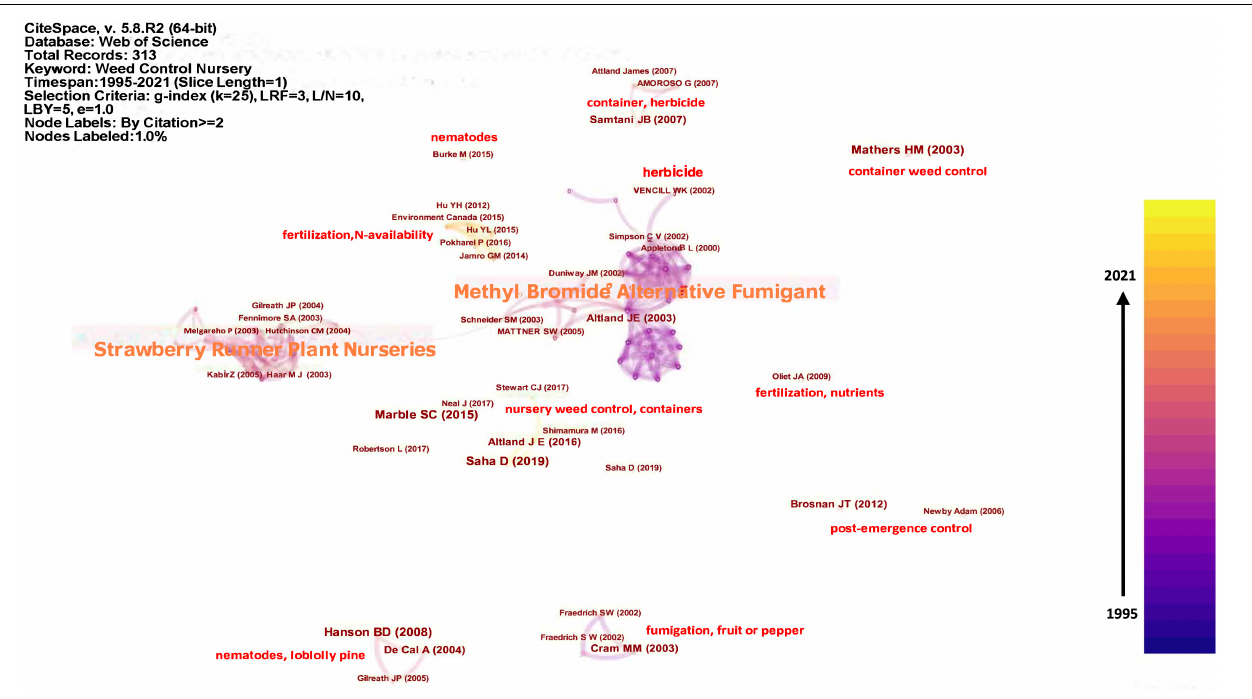
FIGURE 3 | CiteSapce generated knowledge networks from 1995 to 2021. The red texts are keywords derived from the clusters or the literature next to